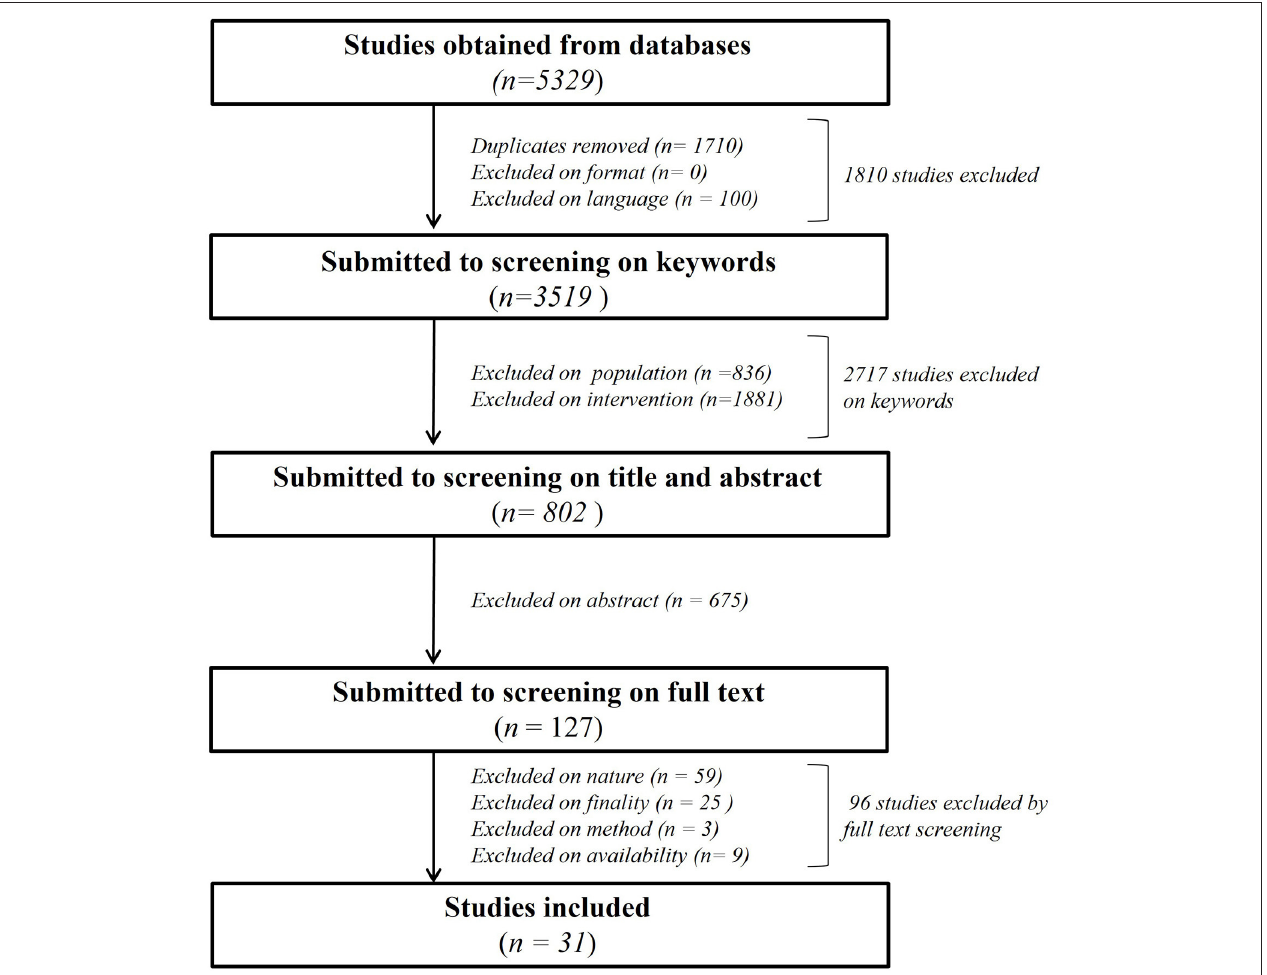
FIGURE 1 | Flowchart of the systematic literature analysis describing all the steps of the manuscript’s selection leading to the 31 analyzed